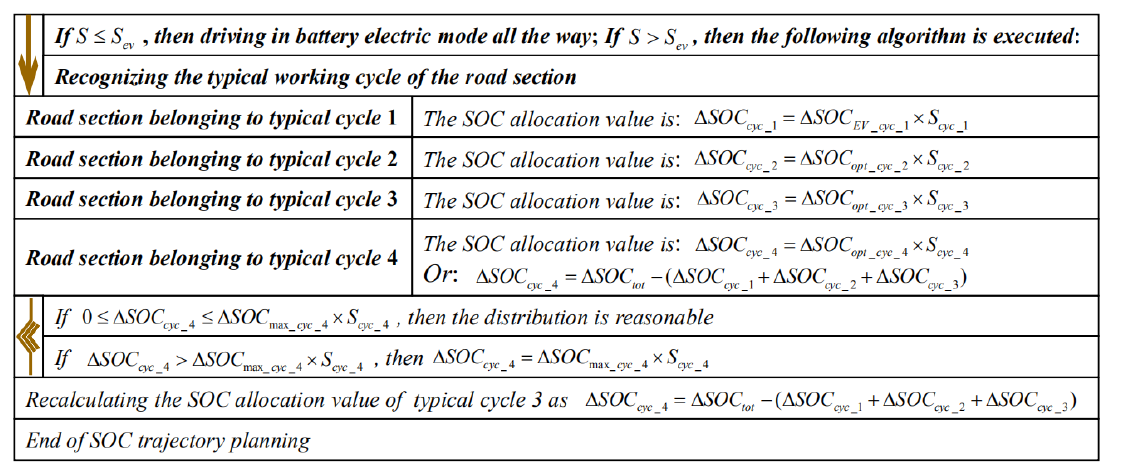
Figure 10. SOC trajectory planning algorithm.